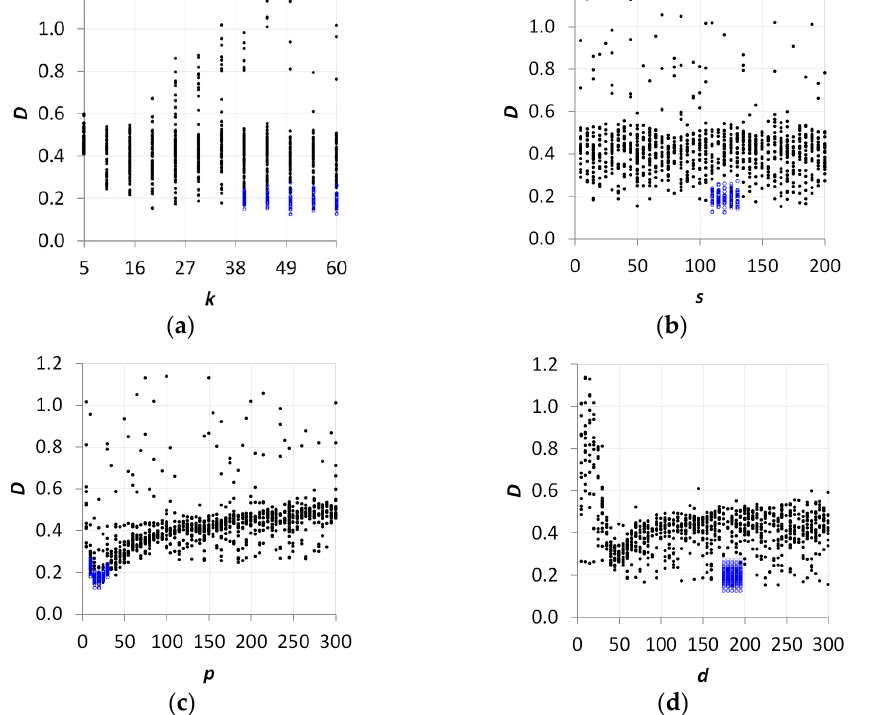
Figure 8. Segmentation parameters optimized on perimeters for the temperate period: ( a ) D versus k ; ( b ) D versus p ; ( c ) D versus s ; ( d ) D versus d , dispersions.